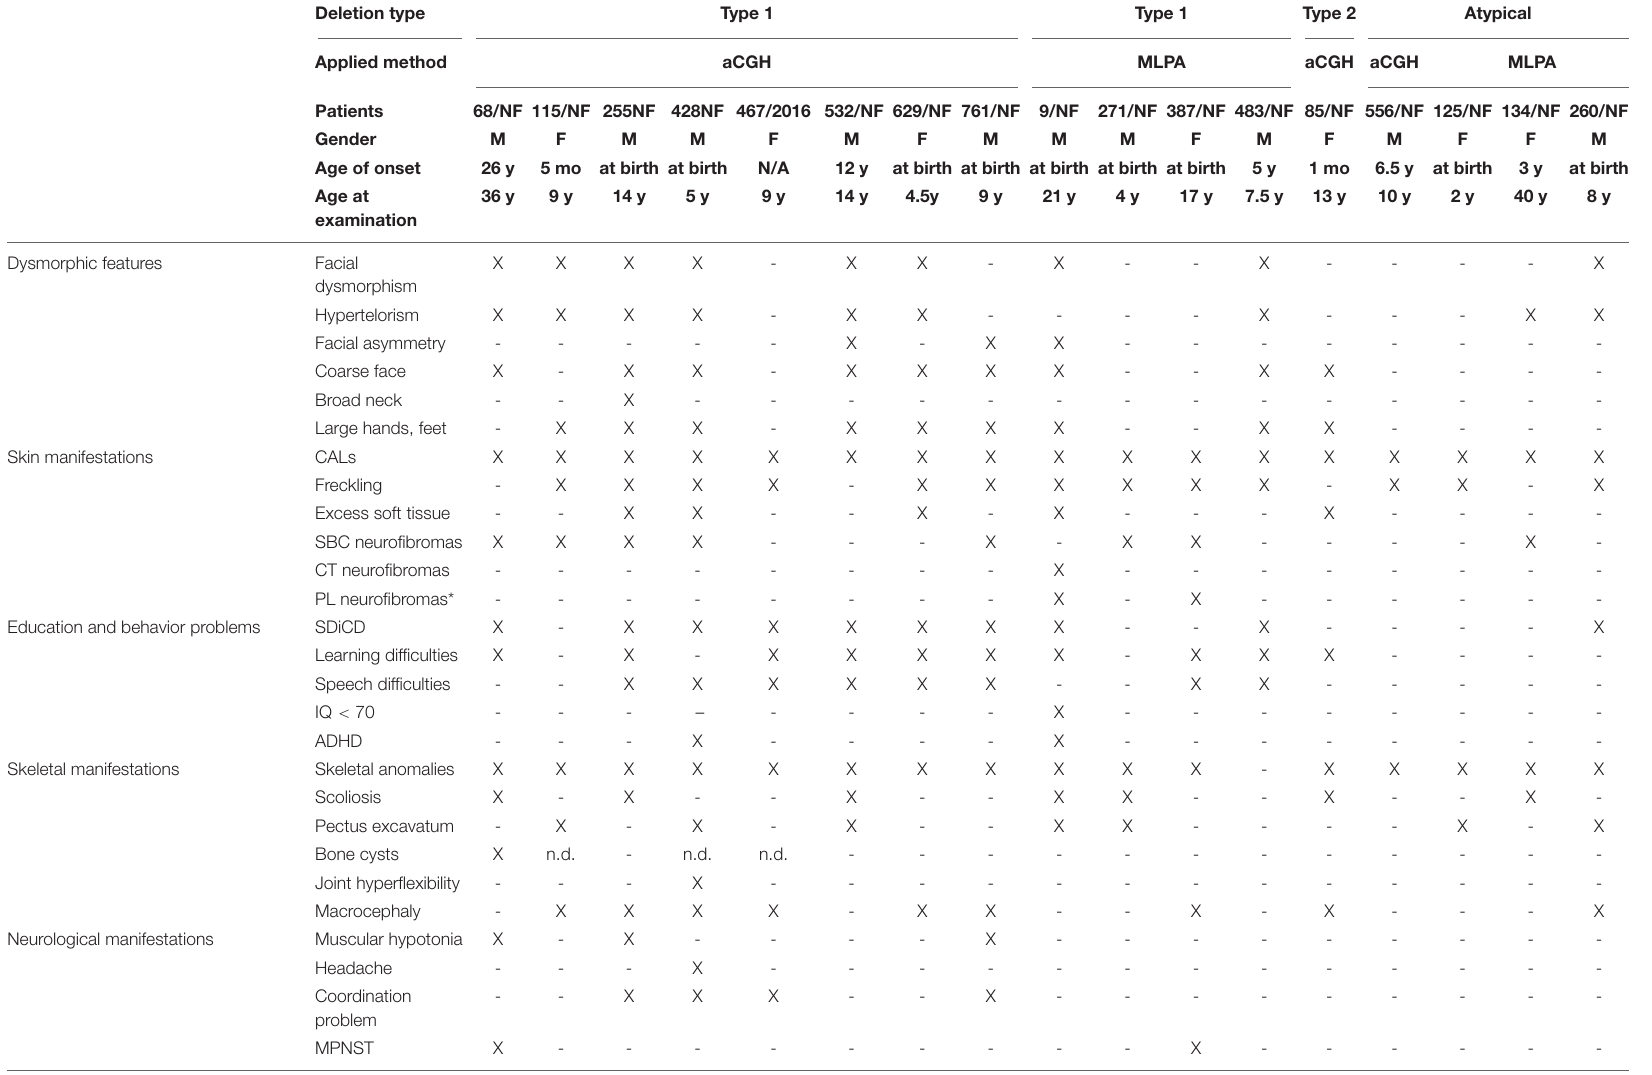
TABLE 1 | Clinical features of our patients with different type of NF1